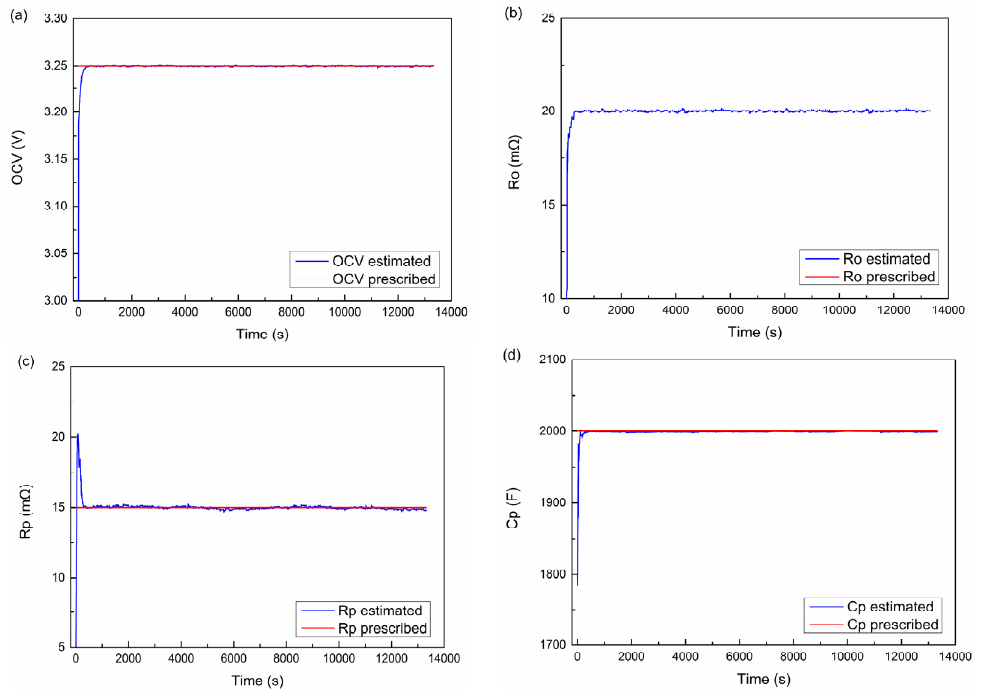
Figure 5. Regression of the estimated parameters based on simulated data: ( a ) OCV; ( b ) R O ; ( c ) R P ; and ( d ) C P